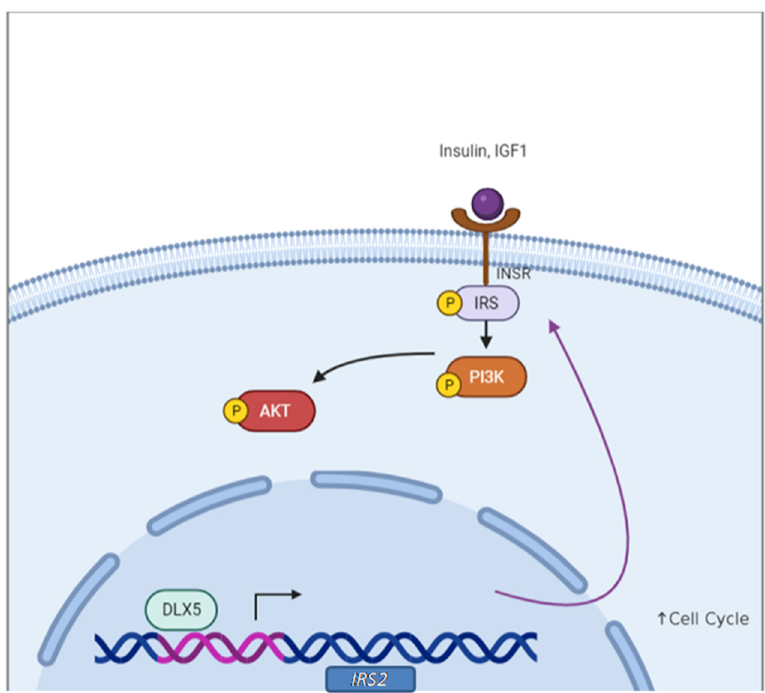
Figure 9. DLX5 upregulates IRS2 expression to enhance AKT signaling. In human ovarian cancer, DLX5 can directly bind to the IRS2 promoter and increase its expression. The resulting elevated IRS2 levels, in turn, augment AKT signaling, which is essential for tumor cell survival.